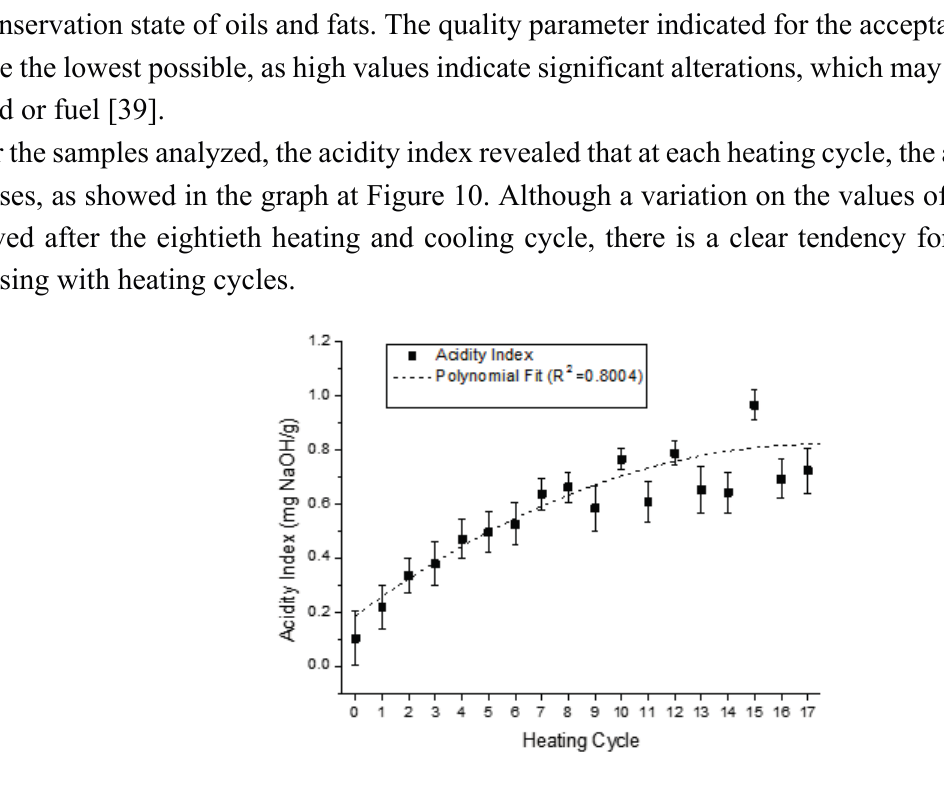
Figure 10. Variation of the acidity index at 20 °C, for each one of the eighteen heating